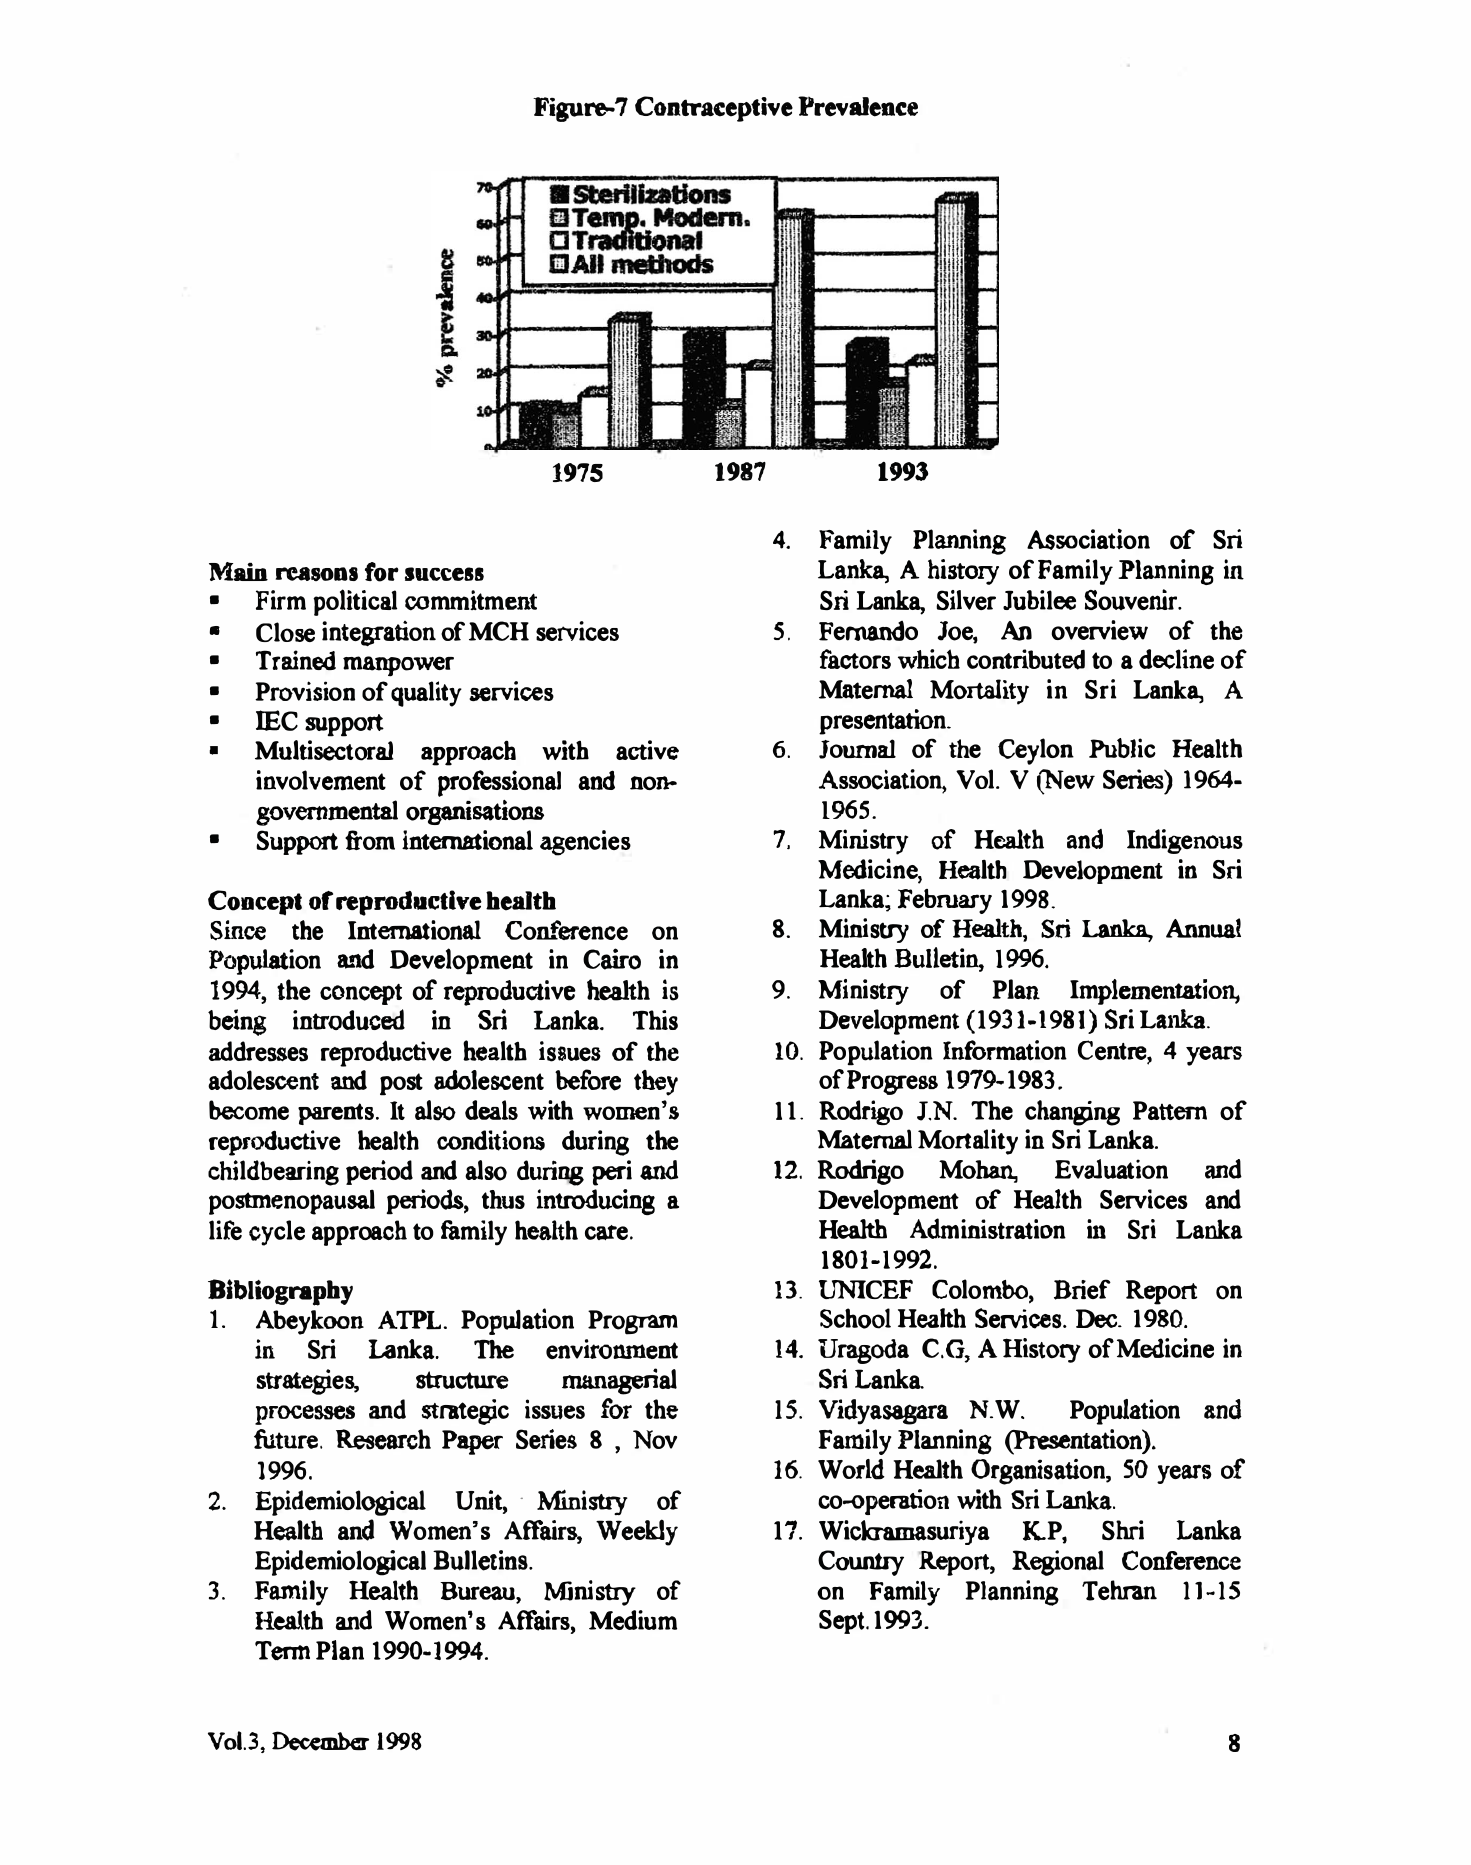
Figure-7 Contraceptive Prevalence